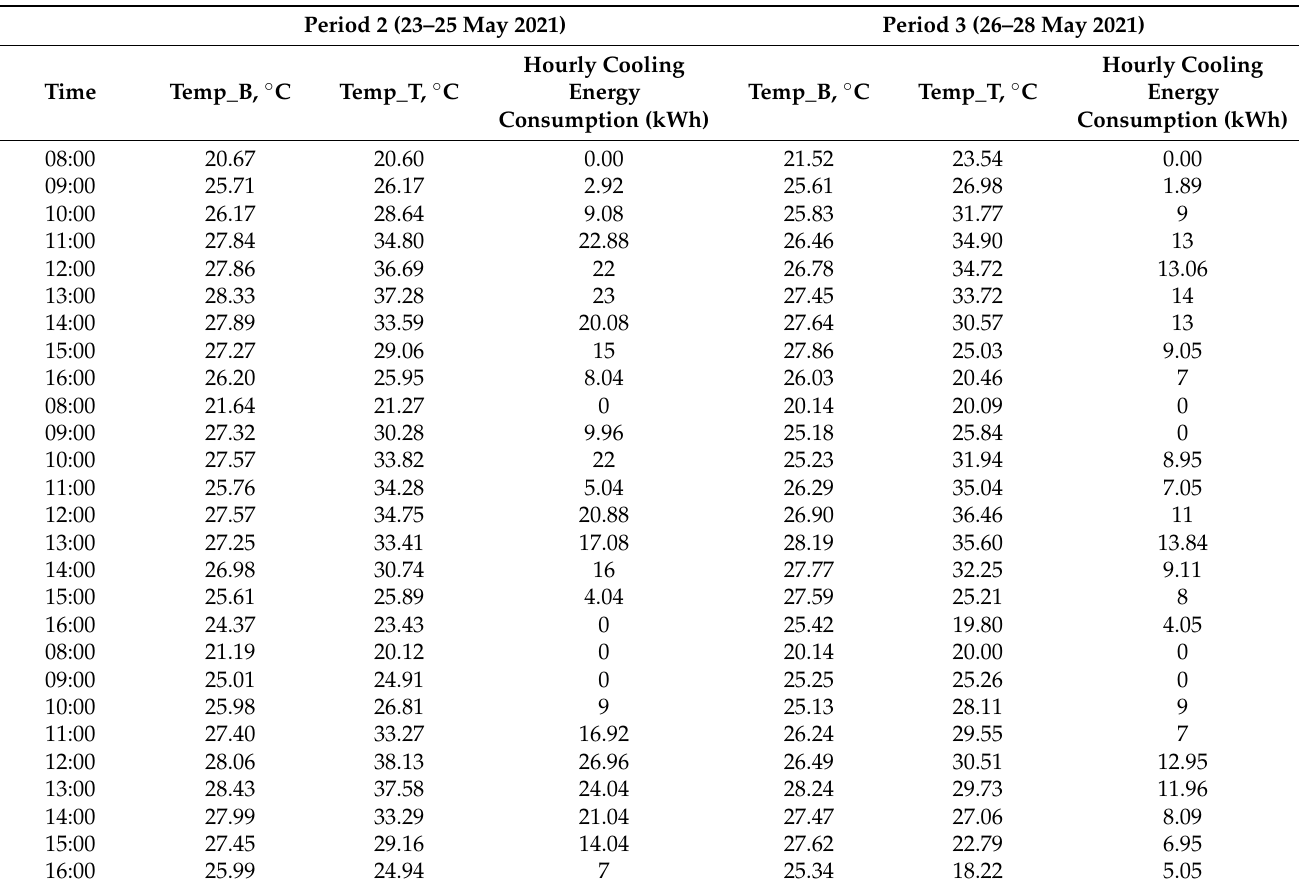
Table A5. Temperature at gutter and rooftop levels and hourly cooling energy consumption, from 08:00 to 16:00 during Periods 2 and